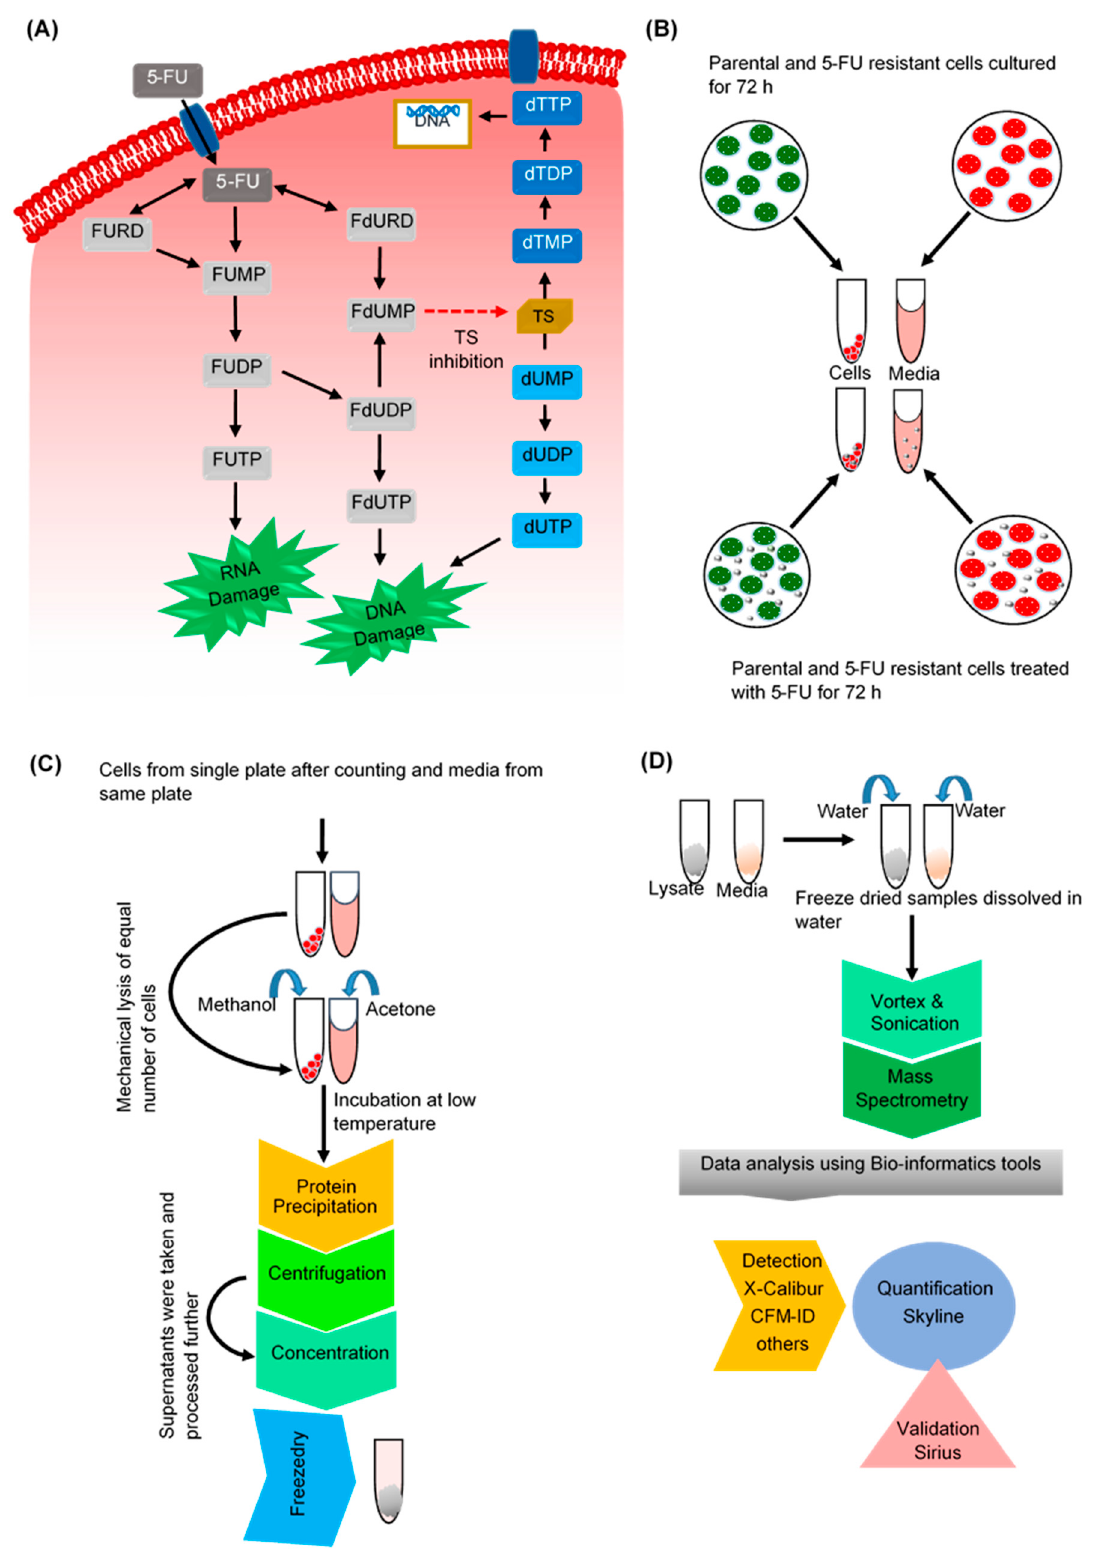
Figure 3. Development of quantitative metabolomics workflow to analyze 5-FU metabolism in CRC cells. ( A ) 5-Fluorouracil (5-FU) is an uracil analogue and within the cells it is rapidly converted into different metabolites. The active metabolites of 5-FU directly or indirectly affect replication and transcription leading the cells to undergo apoptosis. Following entry into the cells, 5-FU gets